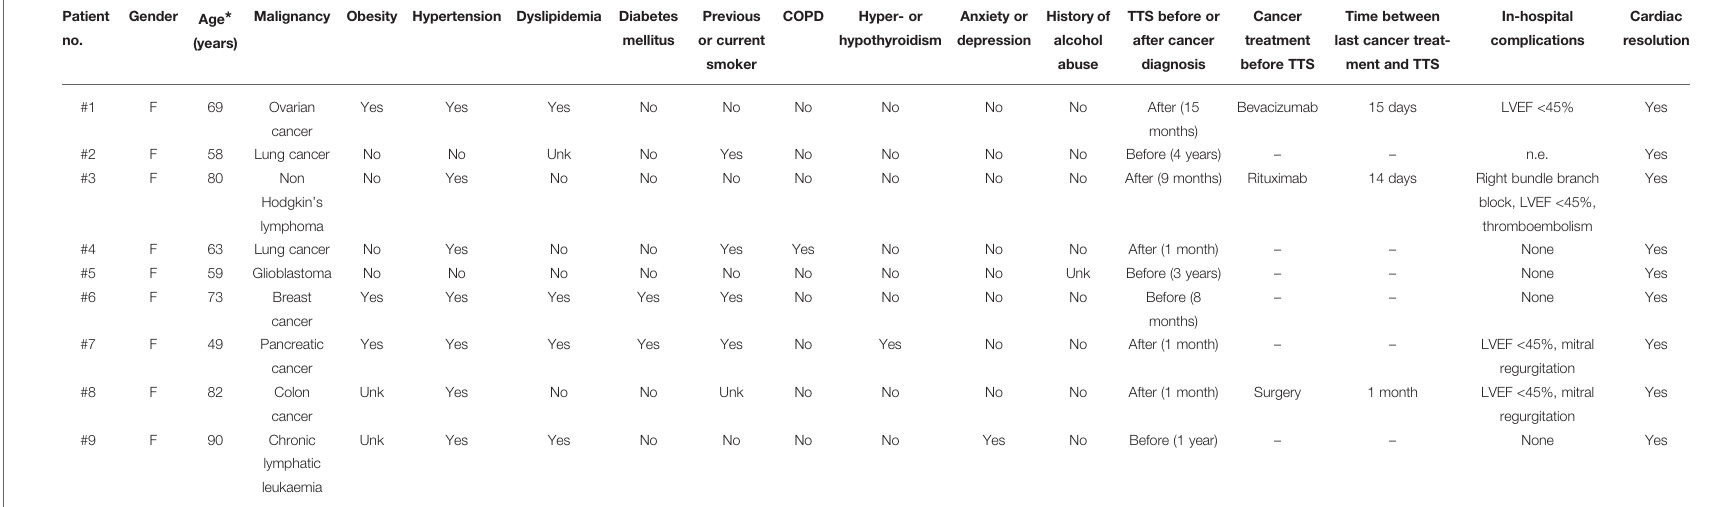
TABLE 1 | Characteristics of patients with diagnosis of malignancies and synchronous or metachronous Takotsubo Syndrome (TTS). Patient